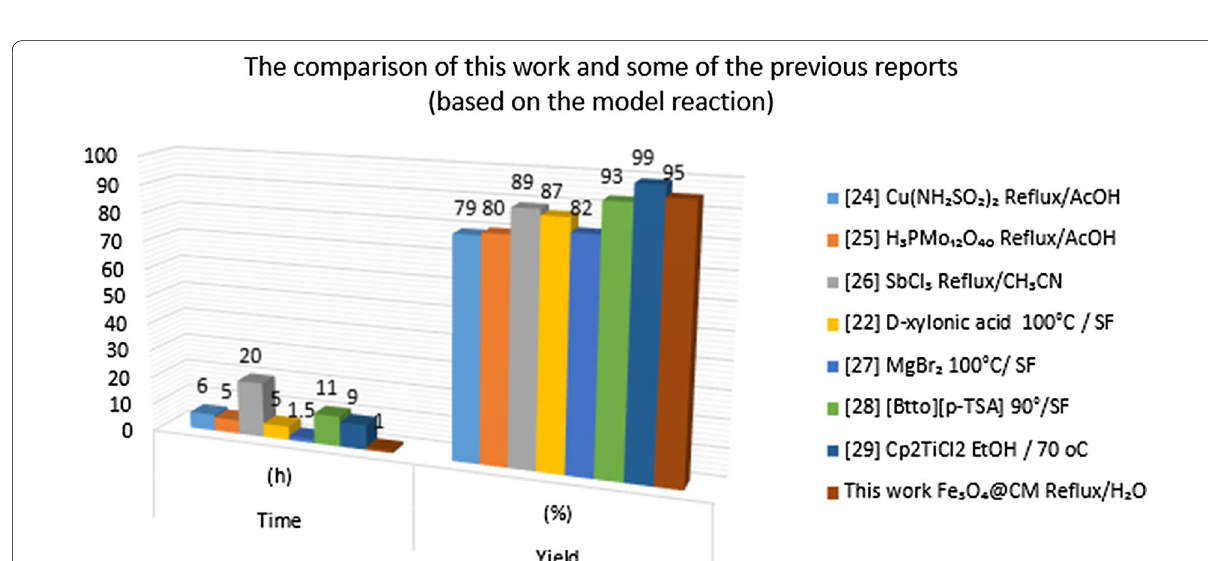
Fig. 7 The comparison of this work and some of the previous reports using various catalysts under different reaction